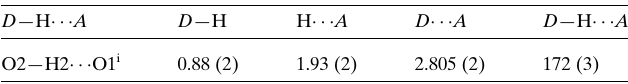
Table 1 Hydrogen-bond geometry (A˚ , (cid:3) ).